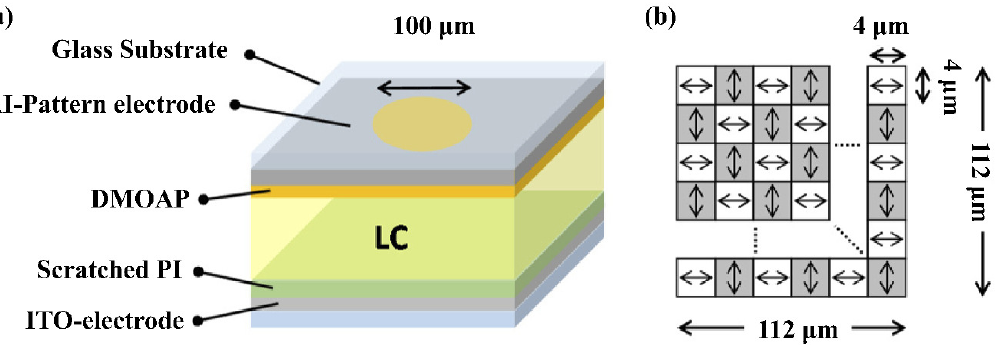
Figure 7. Polarizer-free LC micro-lens. ( a ) Schematic configuration (aperture of a micro-lens: 100 μm). ( b ) The illustration of a scratched PI area in ( a ) [53]. Reprinted with permission from Ref. [53]. 2021 The Optical Society.